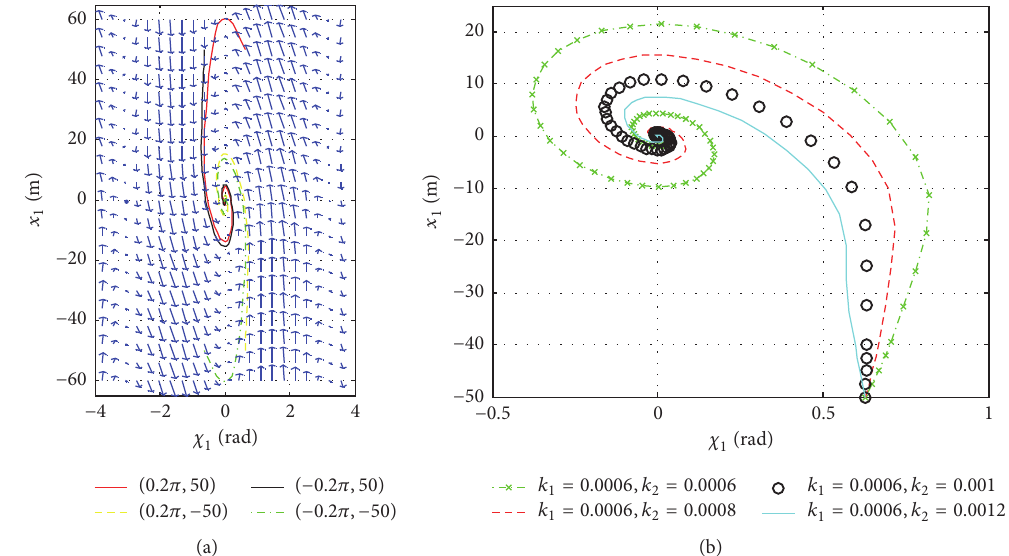
Figure 2: The phase plot of system (10) with ‖∇𝑓‖ = 1 and 𝑉 𝑔 = 20 m/s. (a) Under four kinds of different initial values with 𝑘 1 = 0.0006 and 𝑘 = 0.0008 ; (b) under four kinds of different parameter 𝑘 2